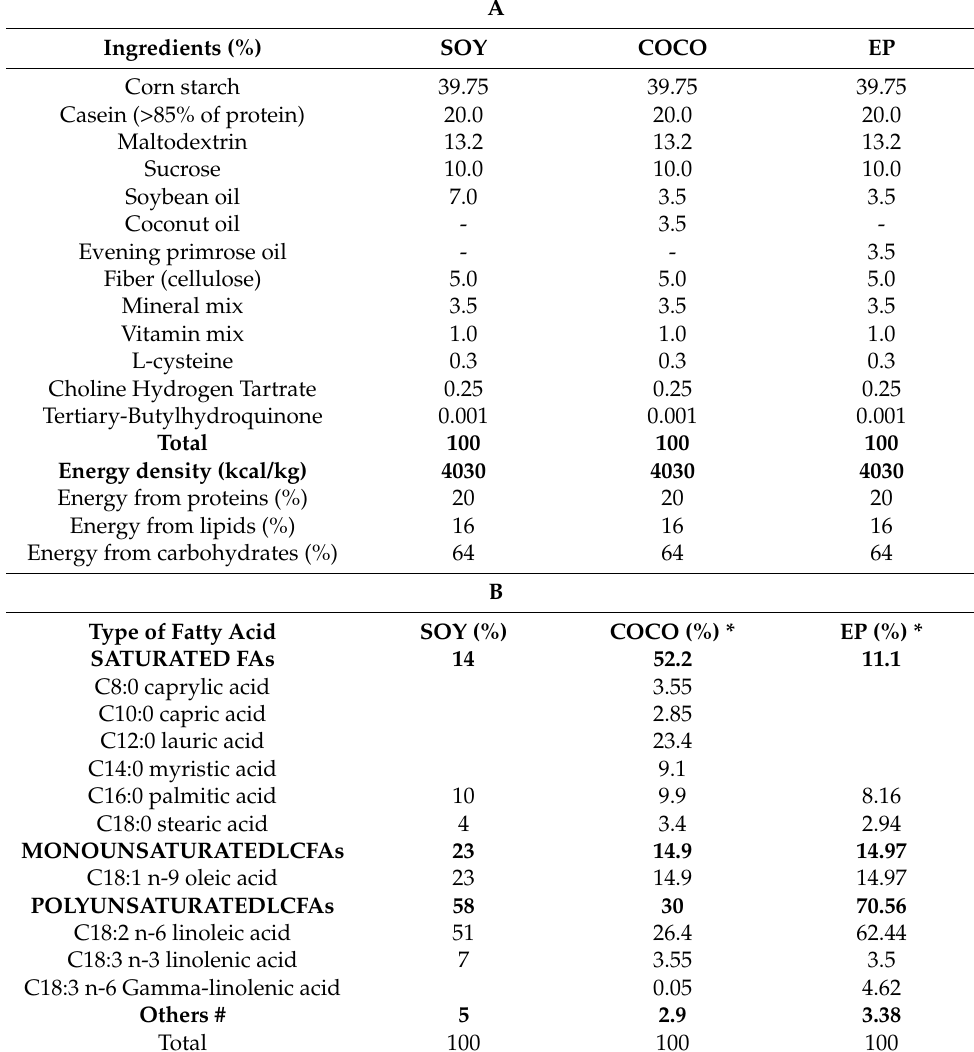
Table 1. Ingredients ( A ) and fatty acids ( B ) in